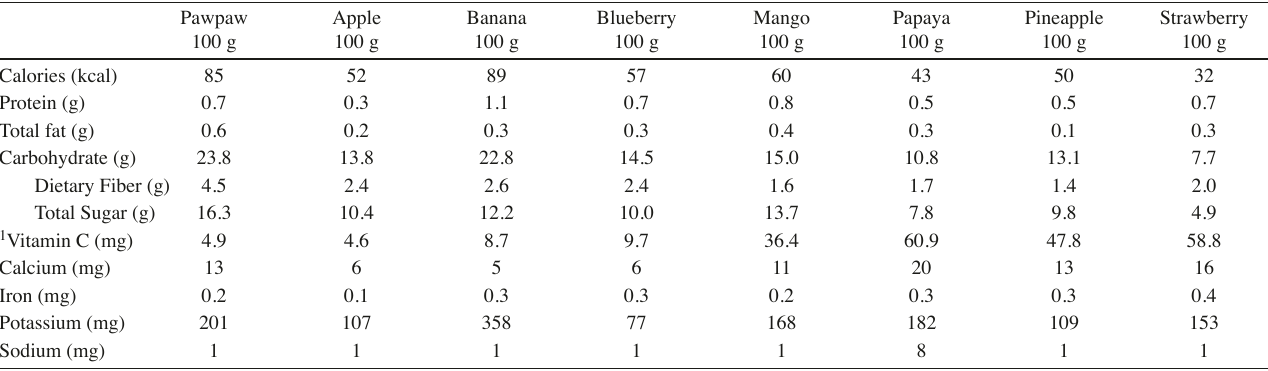
Tab. 6: Comparison of pawpaw pulp nutritional information from this study (except where noted) to existing nutritional information for seven common fruits on a 100-gram basis.